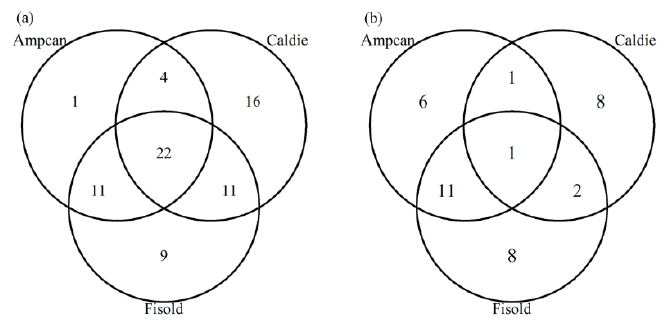
Figure 4. Venn diagram for the number of tree species associated with three liana species in a sub- tropical forest. Panel ( a ) shows the number for positive associations and panel ( b ) for negative as- sociations.